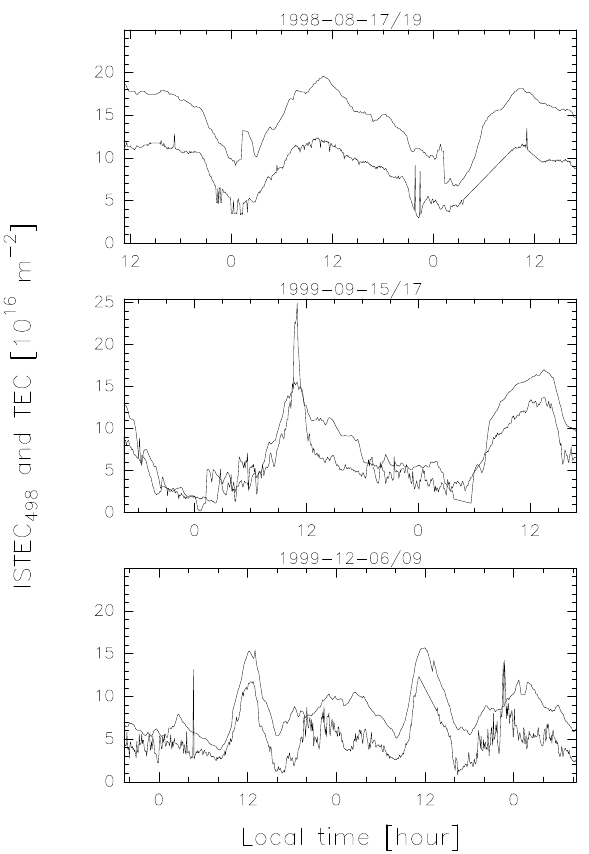
Fig. 7. Comparison between the TECs derived from the GPS sta- tions (thin lines) and the calibrated ISTEC 498 derived from the EIS- CAT measurements (bold lines). Only the three corrected periods are